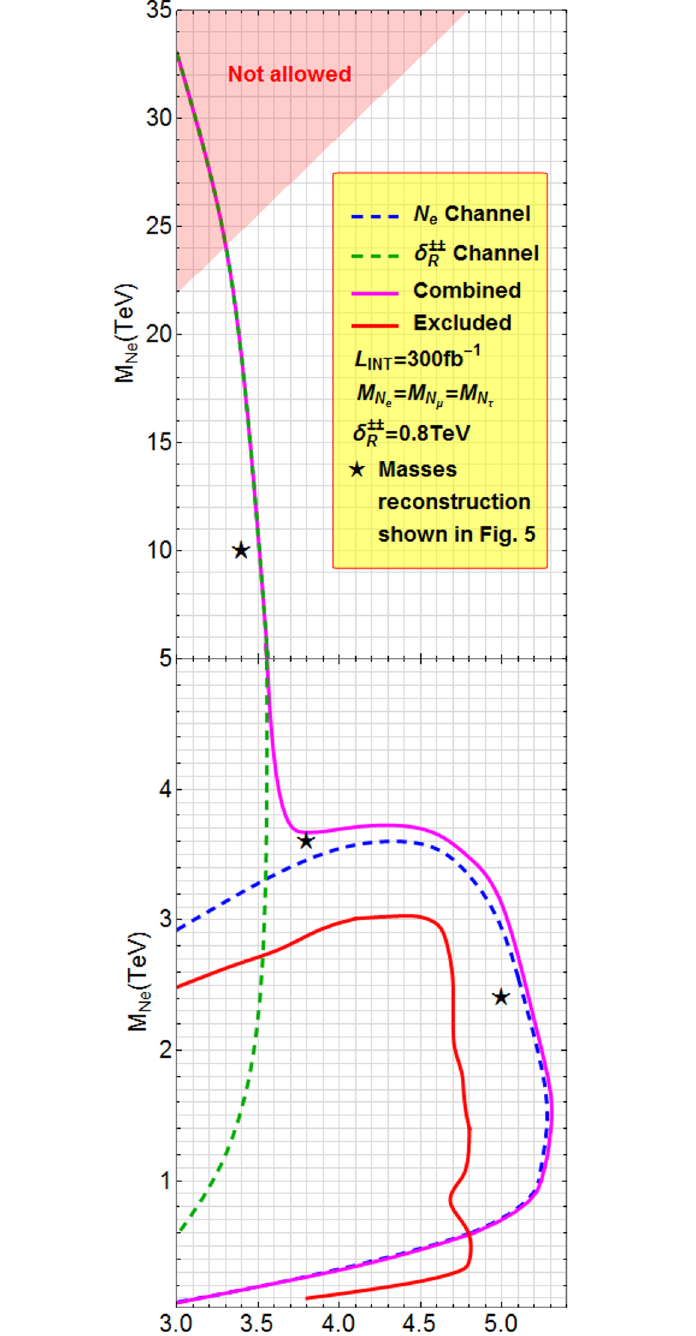
Figure 6. Discovery potential for the two dominant channels of the pp → W R → e ± e ± jj process at the 14 TeV LHC for an integrated luminosity of 300 fb − 1 . The coordinates denoted by F correspond to the three mass settings of figure 5. The red line boundary of the excluded area (i.e. the mass region where no excess of like-sign dilepton events in comparison to the SM was found) is based on the works in refs. [54–57]. The lower and the upper part of the y-axis have different (linear) scales in order to highlight the independent and the combined sensitivity regions associated with the two